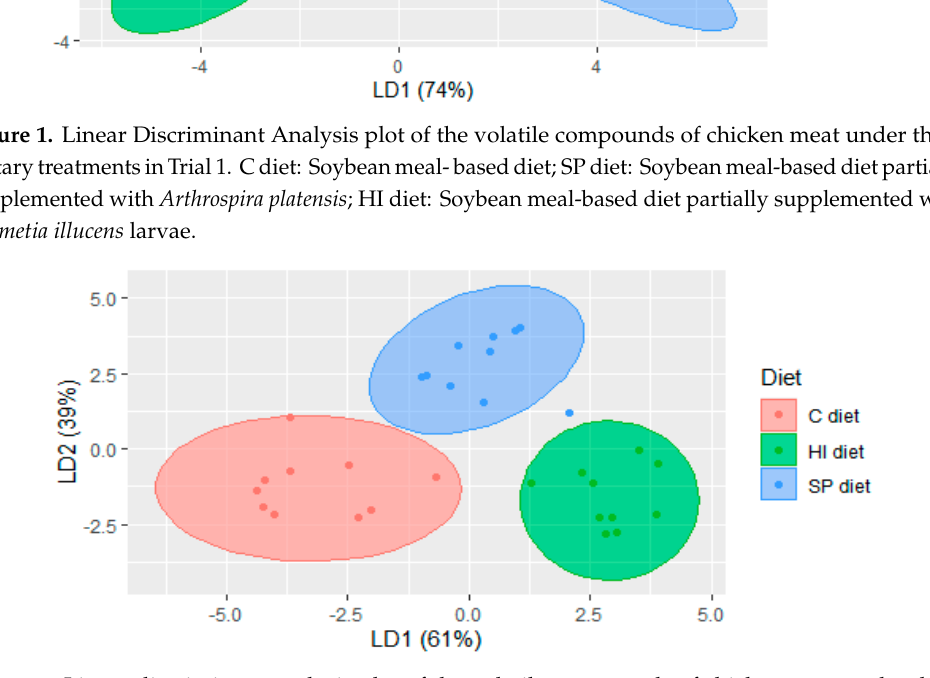
Figure 2. Linear discriminant analysis plot of the volatile compounds of chicken meat under three dietary treatments in Trial 2. C diet: Soybean meal-based diet; SP diet: Soybean meal-based diet supplemented with Arthrospira platensis ; HI diet: Soybean meal-based diet supplemented with Hermetia illucens